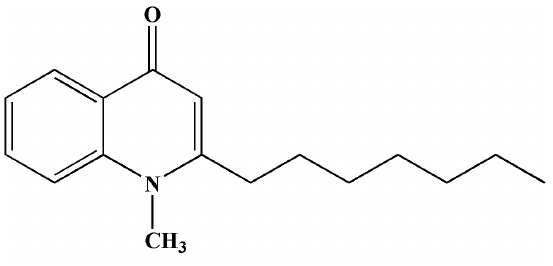
Figure 1. The structure of schinifoline.